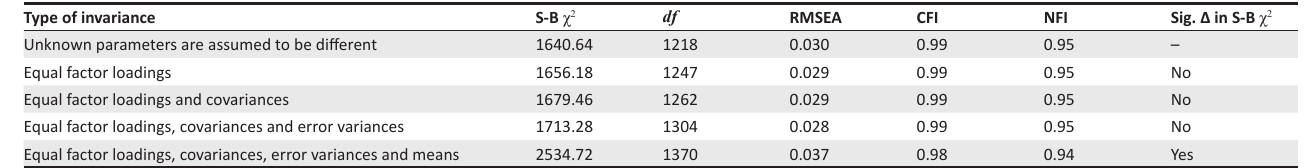
TABLE 3: The cross validation. Type of